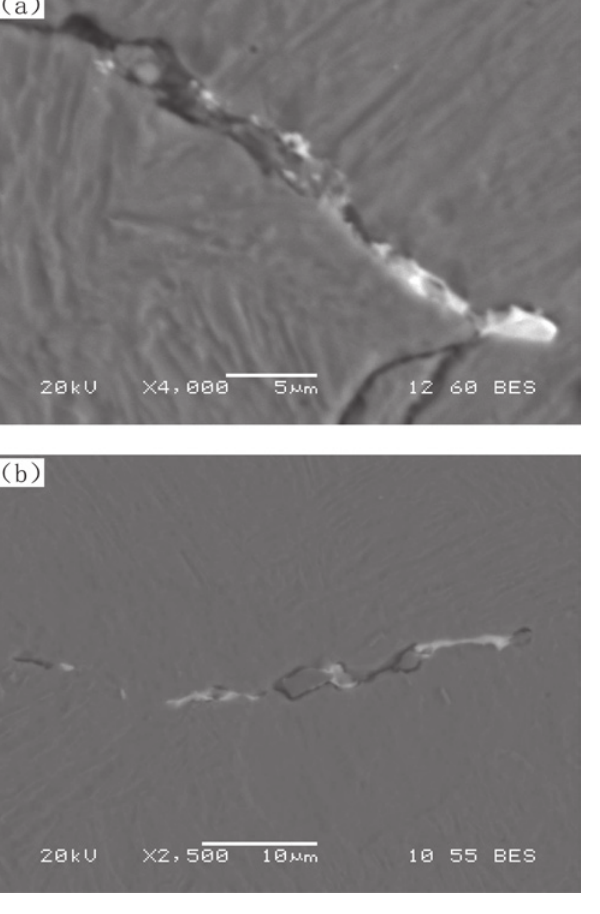
Fig. 10: Typical SEM photos of the bismuth films segregated along austenite grain boundary (BES mode): (a) steel 2 at 1050 °C; (b) steel 4 at 1050